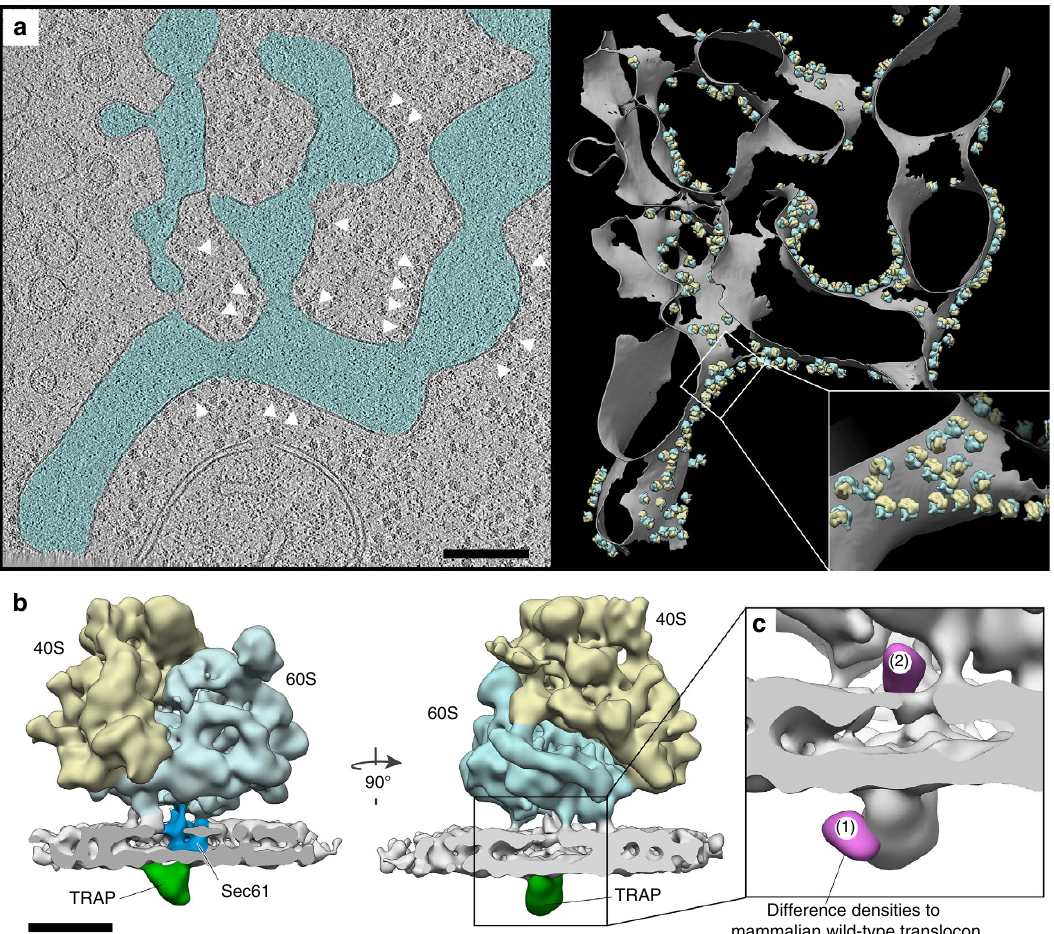
Figure 4 | Structure of an algal translocon reveals the positions of TRAP c and TRAP d . ( a ) Left: slice through a representative tomogram from a FIB-milled vitreous C. reinhardtii cell, depicting a section of the native rough ER network (blue). White arrowheads point to exemplary ER-associated ribosomes. Scale bar, 200nm. Right: 3D rendering of the same tomogram, with the ER membrane depicted in grey and the small and large ribosomal subunits depicted in yellow and blue, respectively. ( b ) Subtomogram average of the ER-associated ribosome within native C. reinhardtii cellular volumes, including the large (blue) and small (yellow) ribosomal subunits, the membrane bilayer (grey), the Sec61 protein-conducting channel (dark blue) and TRAP (green). A total of 8070 subtomograms were averaged. Scale bar, 10nm. ( c ) The difference density map (magenta) between the algal and wild-type mammalian translocons is superimposed on the subtomogram average (grey), revealing two localized areas of high density